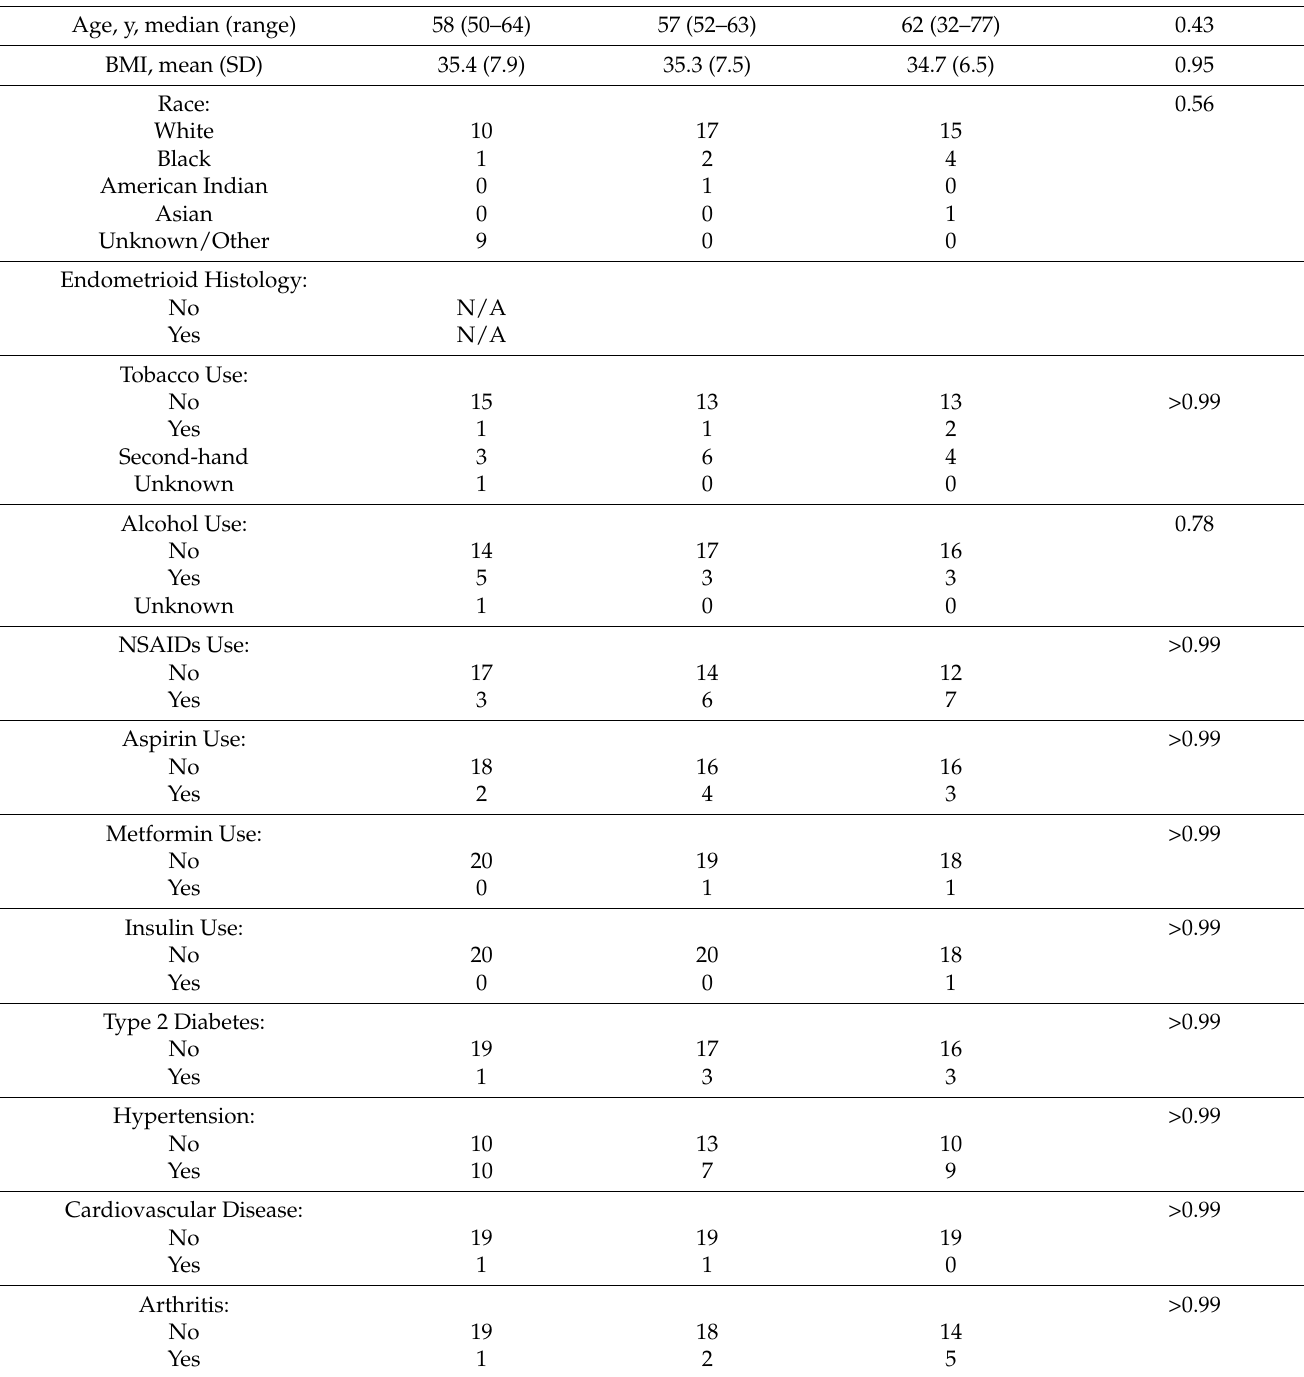
Table 1. Comparison of patient characteristics between